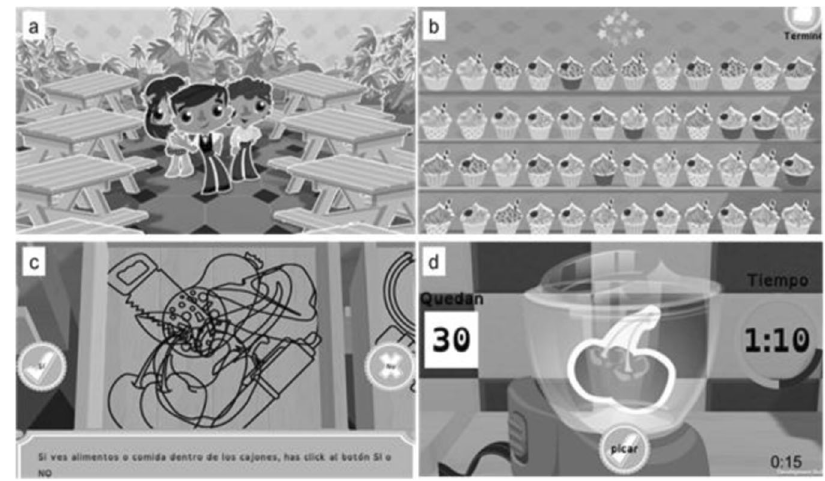
Fig. 1 Examples of Chefmania tasks. (Panel a ) Table allocation, examining orientation. The waiter and the customers are depicted. The player can observe tables on both sides of the screen, that are positioned from the closest as the fi rst table, second table and so on. Following the instructions to seat the diners at a given table, the player will have to visualize himself from the waiter ’ s position by selecting the indicated. (Panel b ) Cupcakes, examining selective attention. A number of cupcakes with different toppings can be observed, a cupcake is shown to the player, who has to choose all the cupcakes with the same topping in a certain time shown at the bottom of the screen. (Panel c ) Choosing ingredients, examining visual recognition. Black silhouettes of different objects such as tools, kitchen utensils of food will appear. The player will analyze the information to distinguish each fi gure separately. On the sides they will have two buttons with the answers ✓ or ✗ . The player will select ✓ in case of recognizing the fi gure of a food. (Panel d ) Chop, examining attention and inhibition. An image of a processor is displayed with the “ chop ” button in the center. Different foods will appear inside the processor, respondents are required to push “ Chop ” when the food is not red. To accomplish the task the player will have to pay attention to each food shown and avoid incorrect responses. The player will observe the number of foods left to chop on the left and on the other the remaining time on the